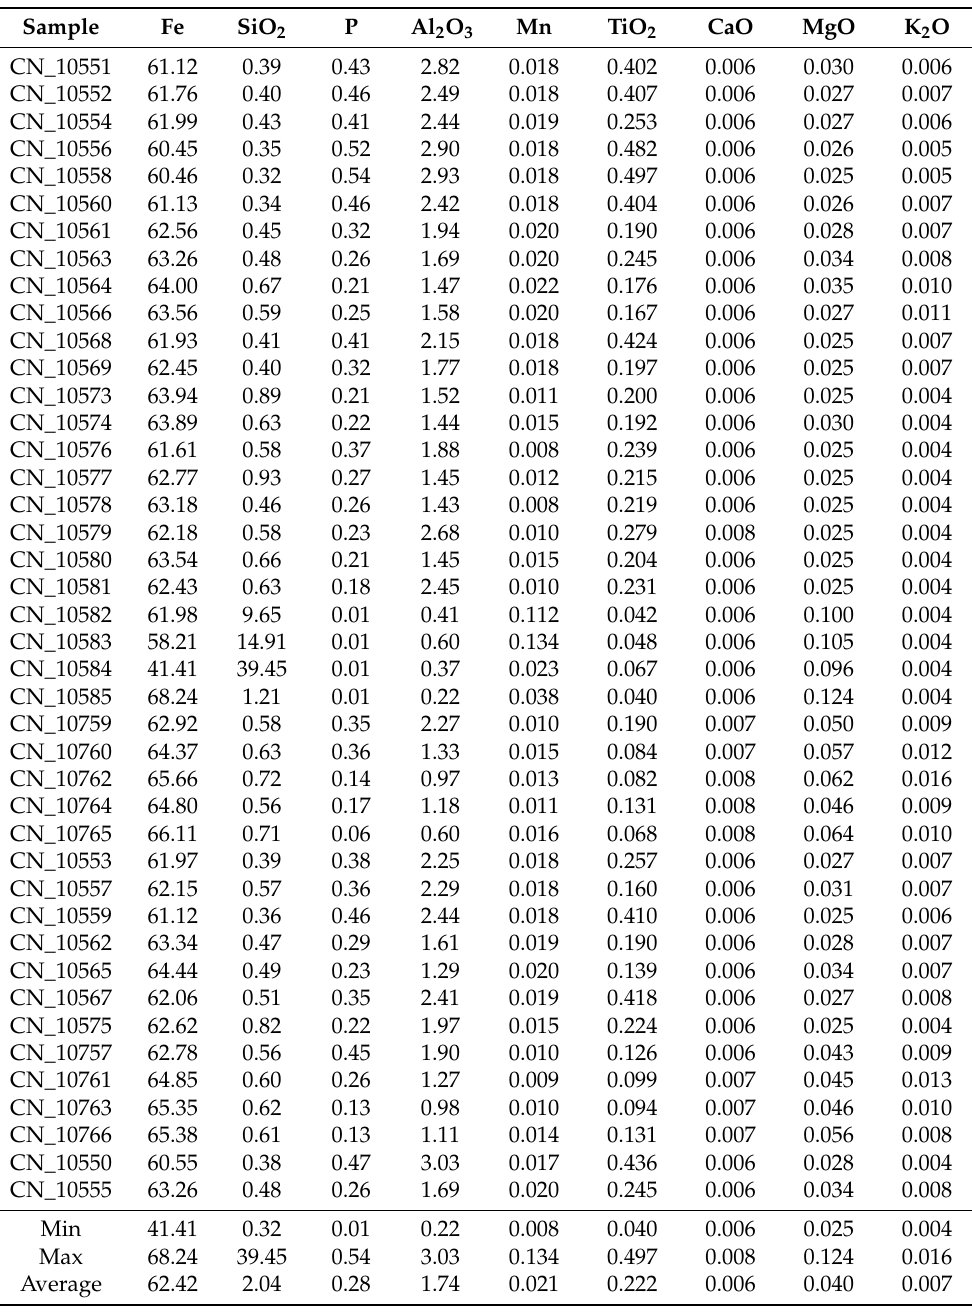
Table 1. X-ray fluorescence (XRF) data of the 42 samples used for model validation training. Column 1 shows the nomenclature of the samples, the first row is the analyzed elements, and the lower portion of the table shows the basic statistical